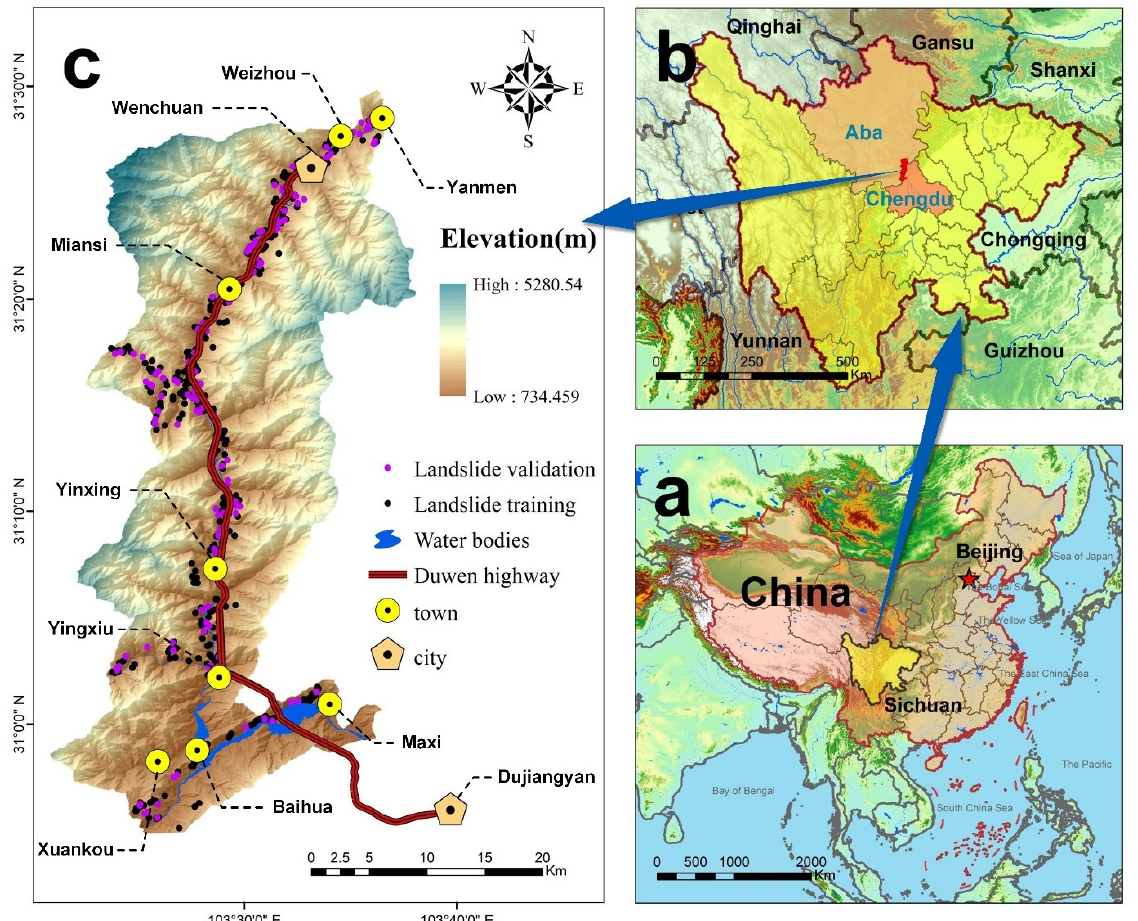
Figure 1. Landslide inventory map and location of the study area: ( a ) location of Sichuan Province in China; ( b ) location of the study area; ( c ) study area and landslide inventory map.